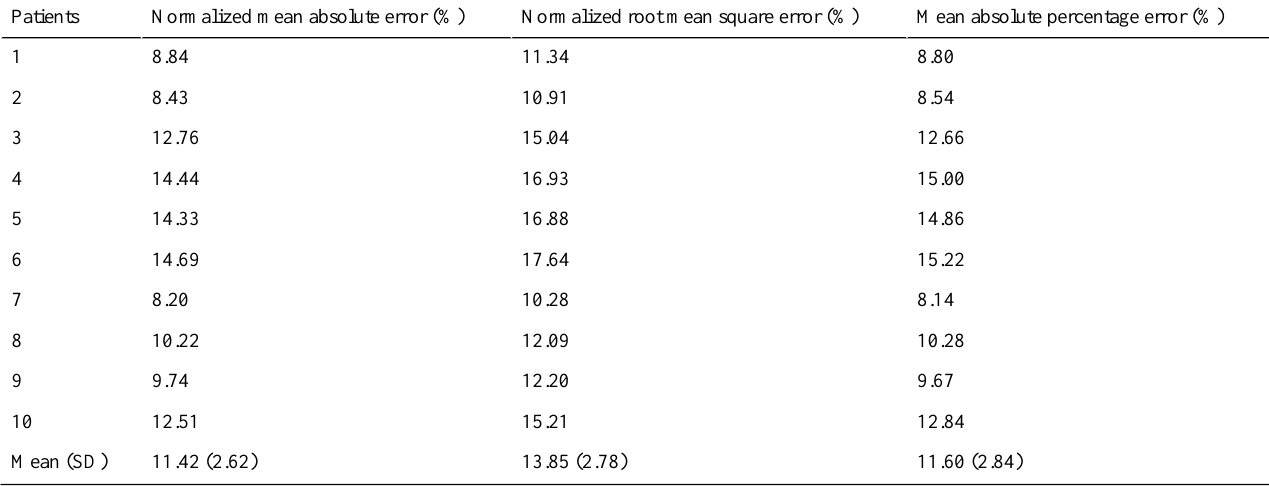
Table 3. Normalized mean absolute error, normalized root mean square error, and mean absolute percentage error for respiratory rate